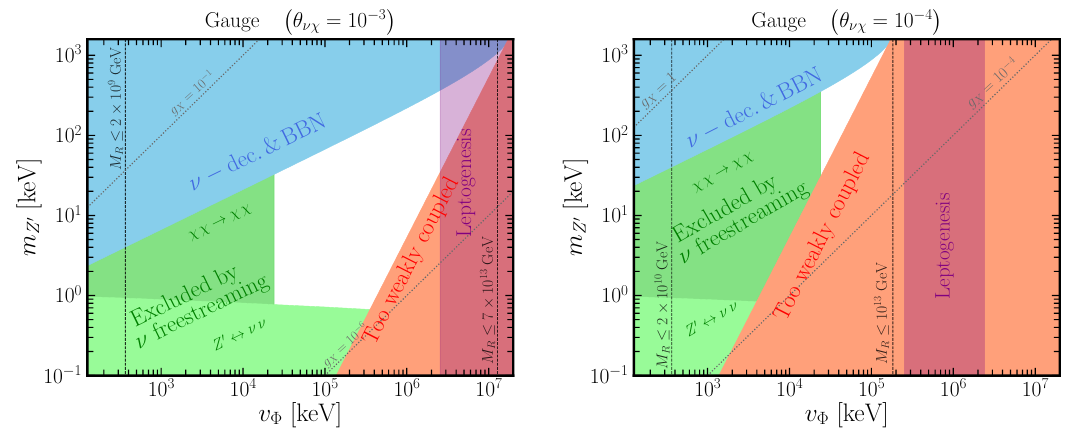
Figure 4 . Regions of the parameter space of the gauge U(1) X model excluded by several cosmological bounds for a value of the mixing between active and massless sterile neutrinos, θ = 10 − 3 (left) νχ and 10 − 4 (right). The white region is allowed. Dotted black lines correspond to the maximum M R value in GeV given by the requirement of perturbativity for Y , see eq. (5.3), or by the requirement Φ of λ 10 − 6 when stronger, see eq. (5.5). The grey dotted lines indicate regions of constant value H Φ ≤ of the gauge coupling constant g = m . We also indicate the region where standard thermal X Z 0 /v Φ leptogenesis can work (purple